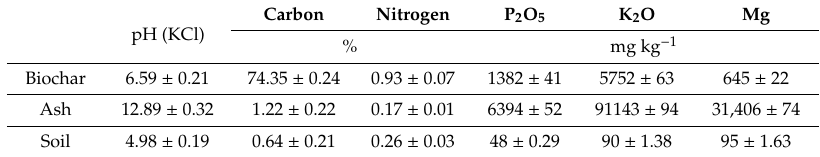
Table 1. Mean pH, macro-elements, carbon, and nitrogen ( ± SD) in the biochar, ash, and soil ( n = 3).